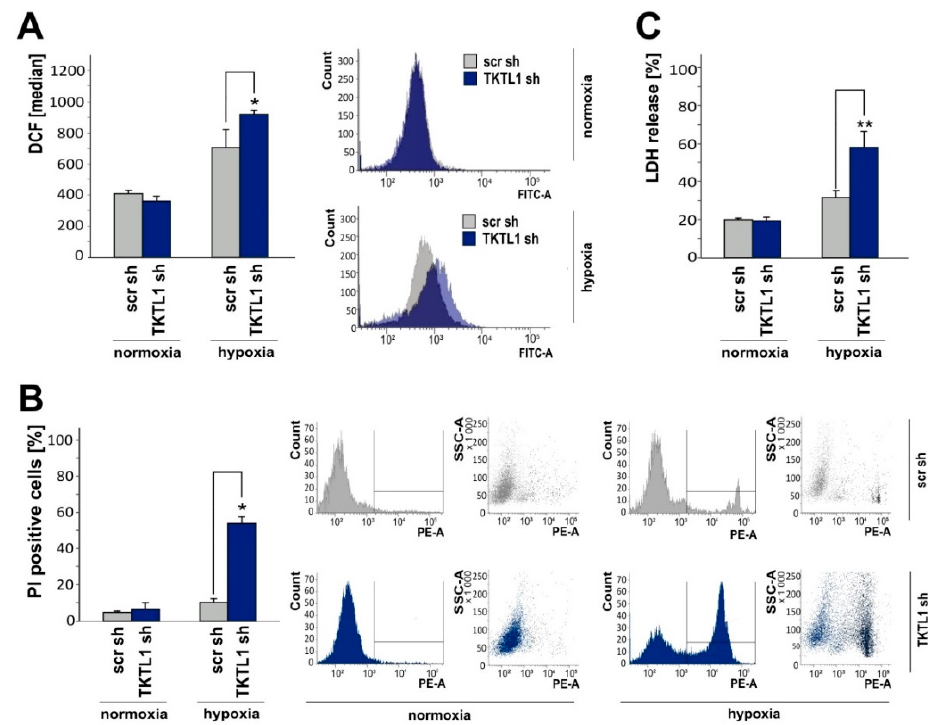
Figure 4. In hypoxia, TKTL1 gene silencing increases reactive oxygen species ( ROS) levels and cell death. ( A ) LNT-229-shTKTL1 and control (scr) cells were cultured in serum-free medium supplemented with 5 mM glucose under normoxic or hypoxic conditions for 24 h. Thereafter, intracellular ROS were evaluated using H 2 DCFDA and flow cytometry (median fluorescence intensity, mean + SD, * p < 0.05). Using medium containing 2 mM glucose, cell death was assessed by PI staining after a 36 h incubation (( B ), mean percentage of PI-positive cells + SD, * p < 0.05) and by quantification of LDH release after a 72 h incubation (( C ), mean + SD, ** p < 0.01).